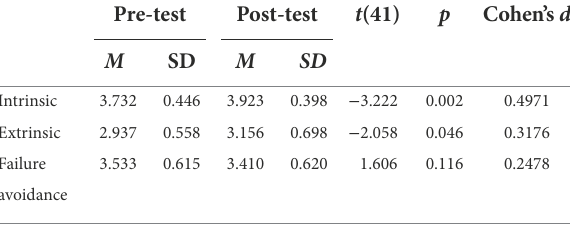
TABLE 3 Statistics of three research motivation categories in pre- and post- tests.